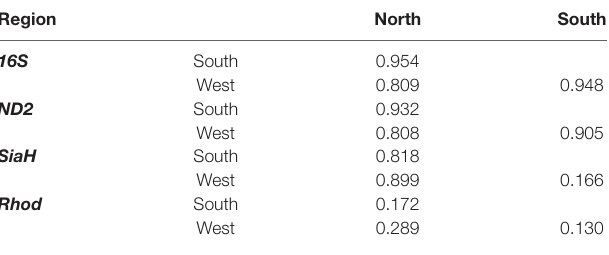
TABLE 2 | Pairwise Φ ST values between north, south, and west groups recovered in BAPS analysis of the P. nordestinus populations. In bold, the statistical significant results.